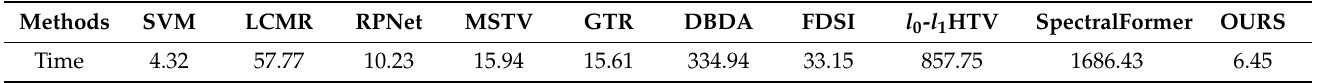
Table 5. The computing time (seconds) of different methods for Salinas.